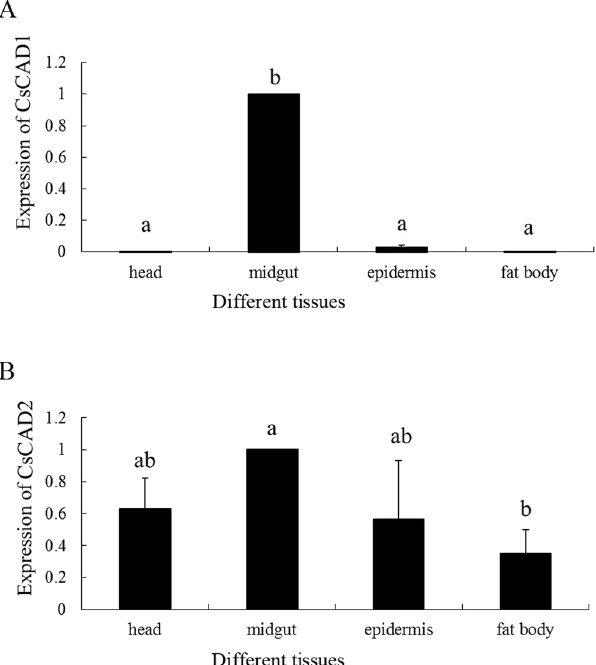
Figure 3. Relative abundance of mRNA of the Chilo suppressalis cadherin genes ( A ) CsCAD1 and ( B ) CsCAD2 in different body parts. Results are means ± SE. Bars with the same lowercase letter are not significantly